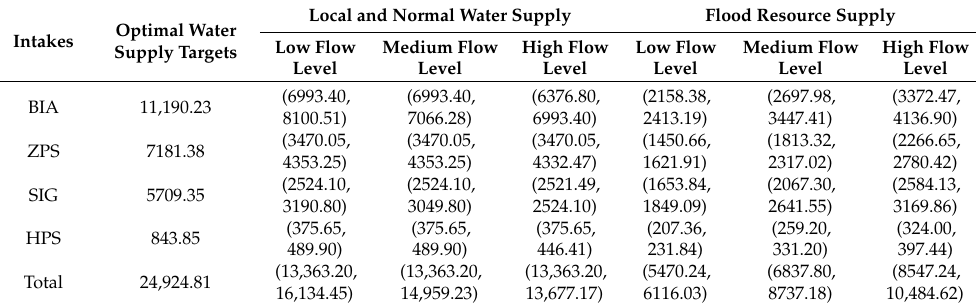
Table 1. Optimal water supply targets and the ecological water supplement optimization schemes under three scenarios (104 m 3 /